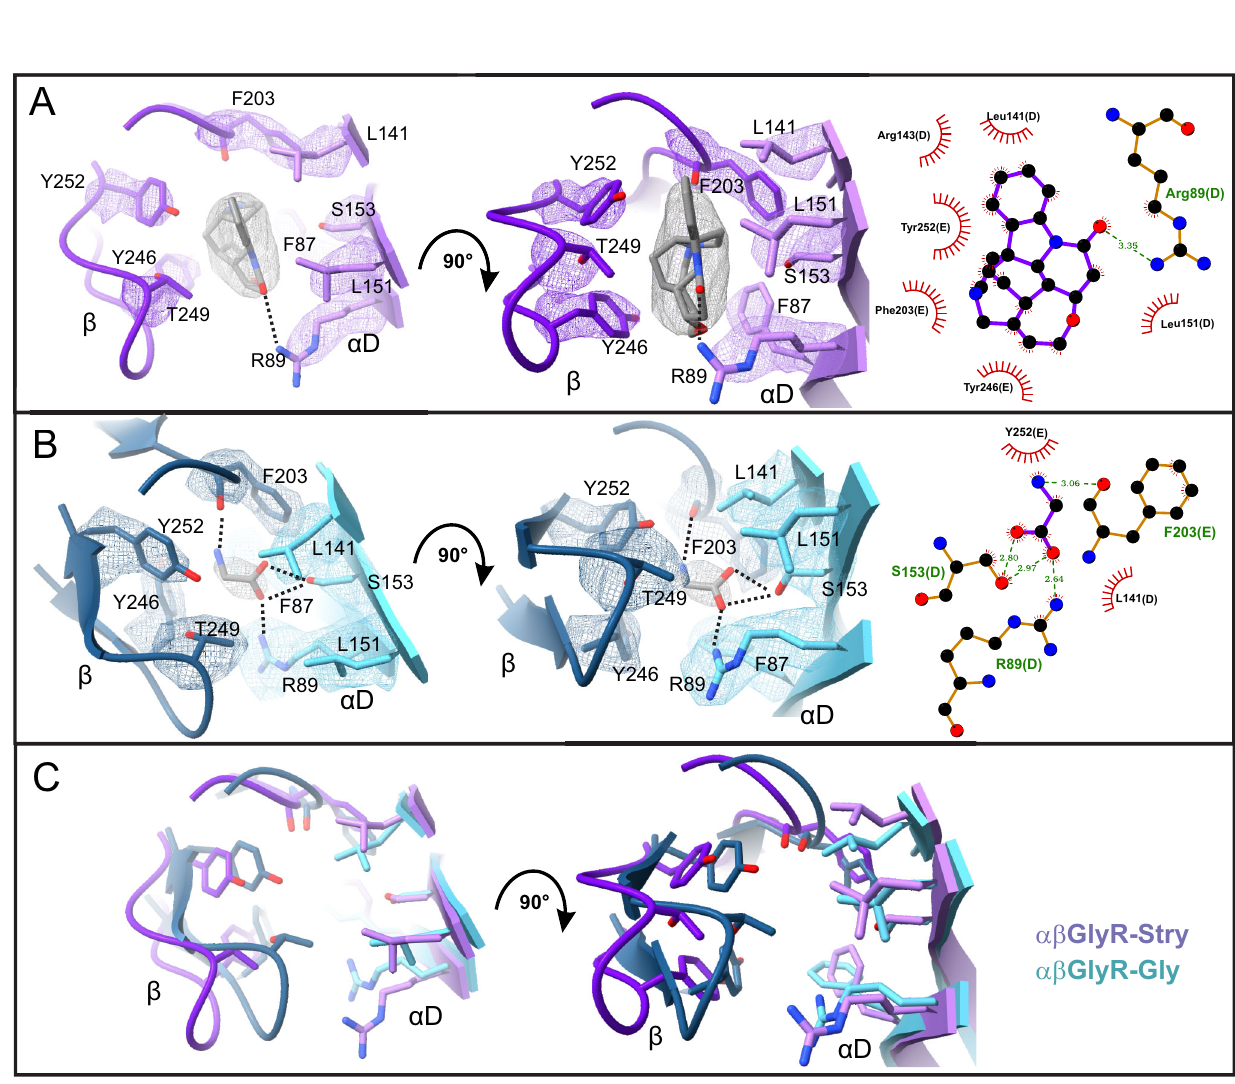
Fig. 5 | Strychnine and glycine within the canonical binding site. The binding pocket for A strychnine in αβ GlyR-Stry and B glycine in αβ GlyR-Gly shown at dif- ferent angles. Map density is shown at σ =0.3 and σ =0.55 for strychnine and